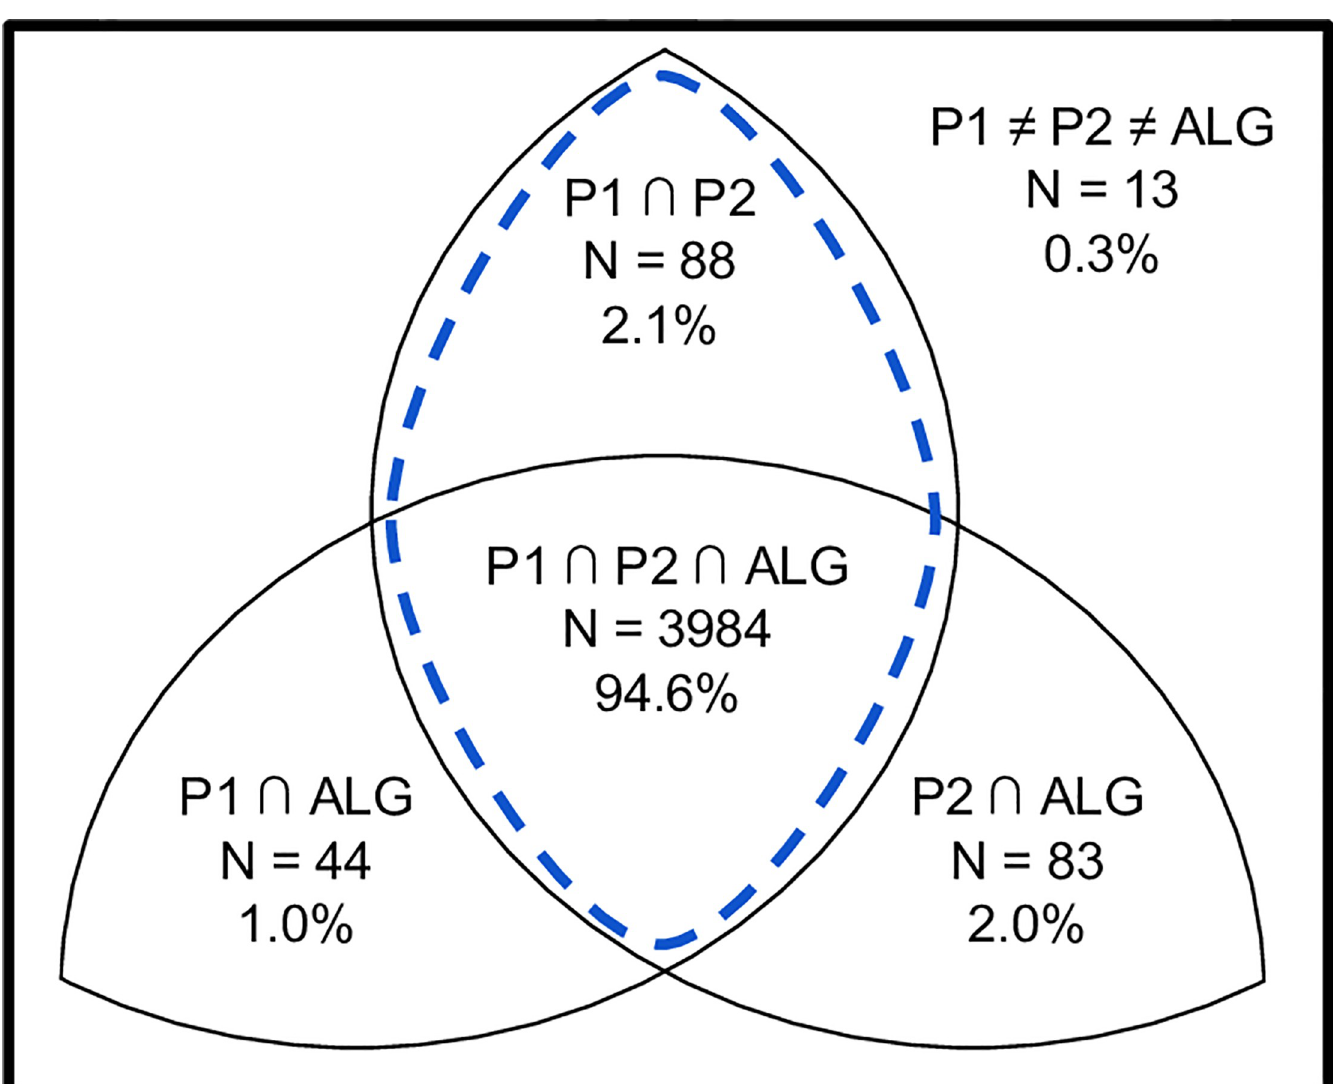
Fig 4. Annotation overlap. Diagram depicting the overlap in annotations for two annotators (P1, P2) and tbiExtractor (ALG) in validation dataset. Dashed line indicates gold standard (i.e., where two annotators are in